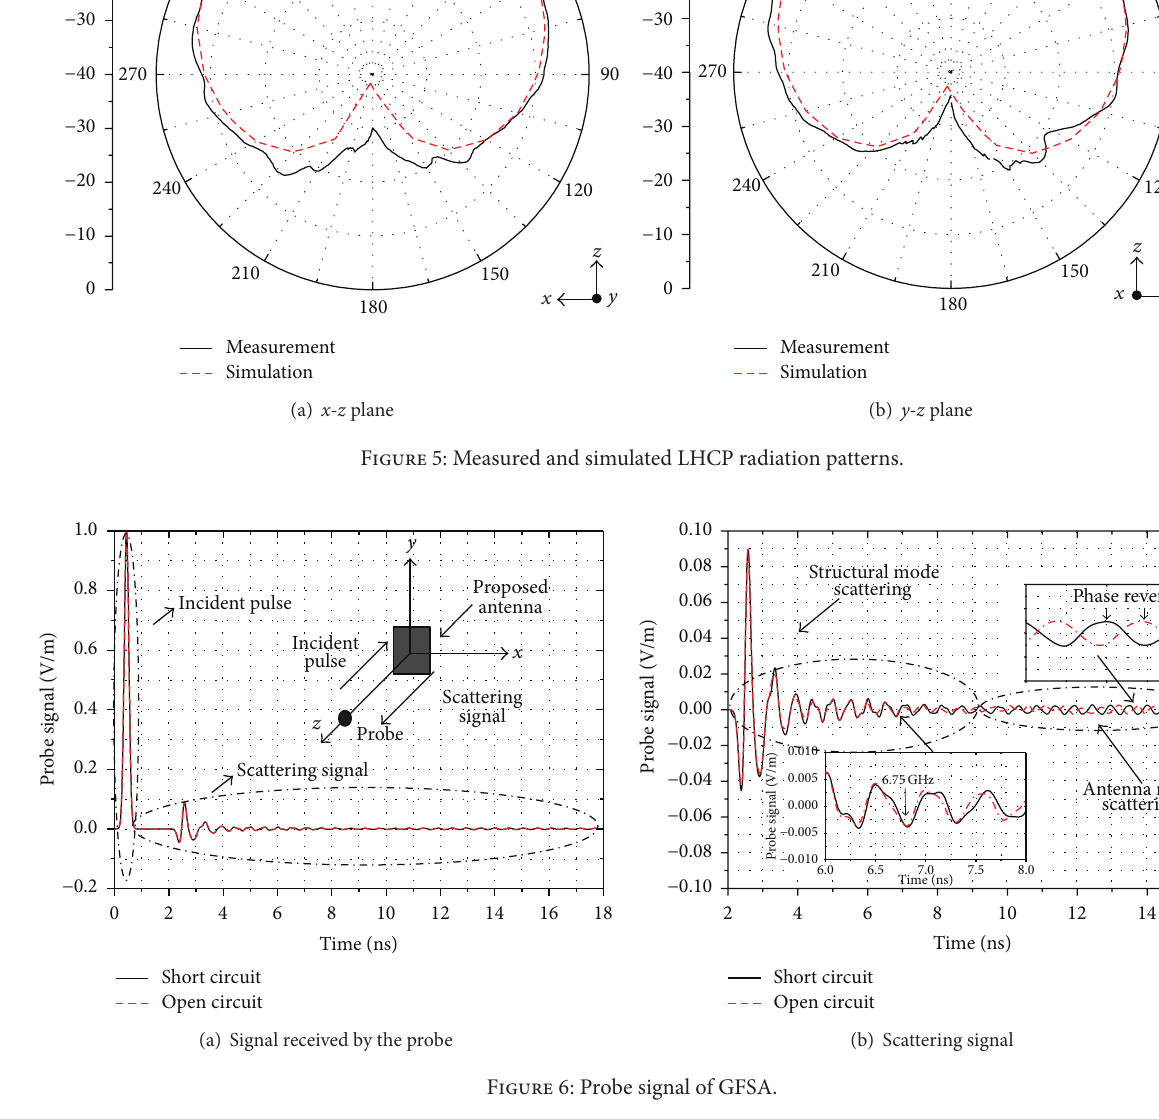
Figure 6: Probe signal of